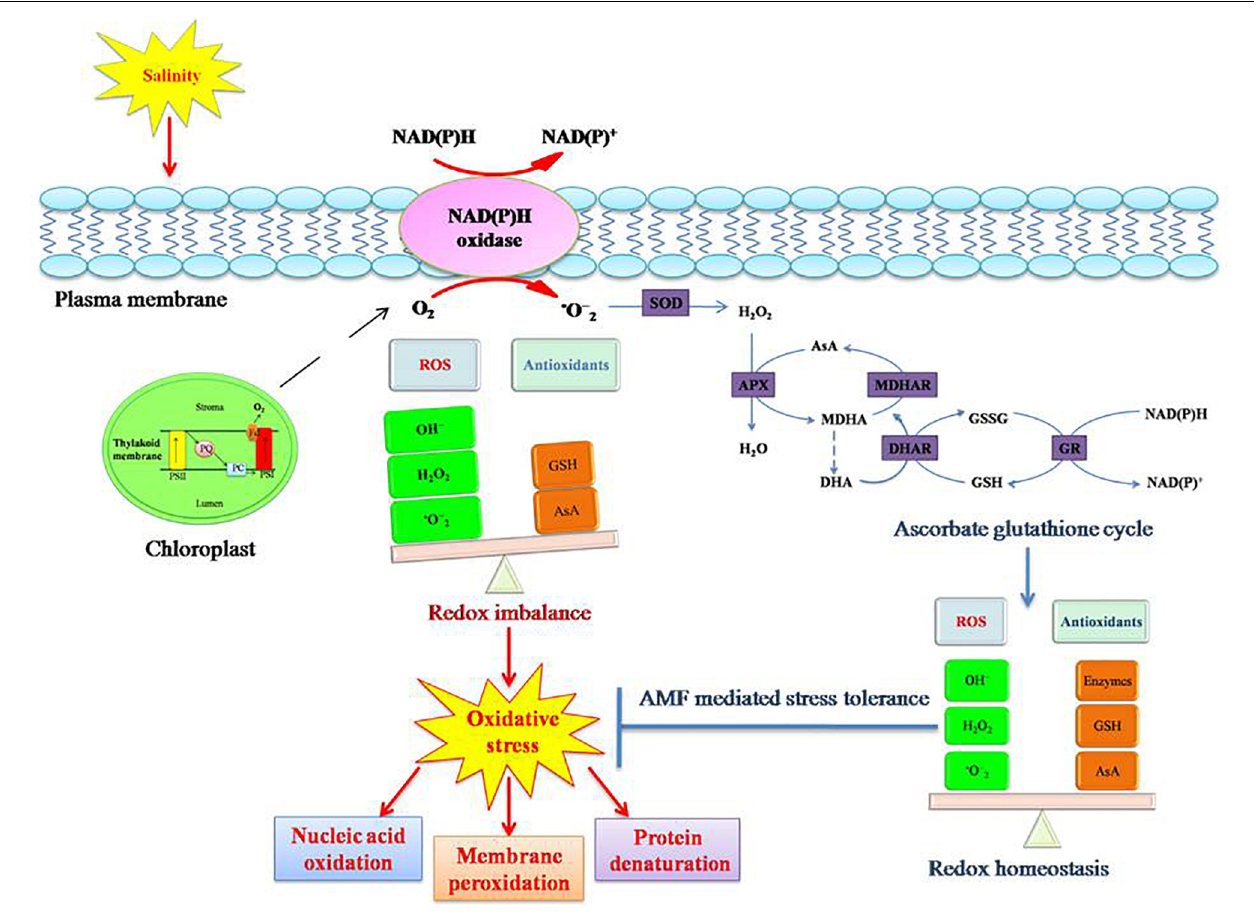
FIGURE 4 | Salinity stress induced oxidative stress tolerance mechanism in plants. Salinity causes oxidative stress in plants due to redox imbalance resulting from disturbance in equilibrium between ROS (reactive oxygen species) and antioxidants. Increased ROS concentration in the cell results in protein denaturation, membrane peroxidation, and nucleic acid denaturation. This consequently disturbs the normal functioning of the cell. To counteract the adverse consequences, plants induce antioxidative pathways (enzymatic and non-enzymatic). Enzymatic antioxidants include superoxide dismutase (SOD), peroxidase (POX), catalase (CAT), ascorbate peroxidase (APX), monodehydroascorbate reductase (MDHAR), dehydroascorbate reductase (DHAR), and glutathione reductase (GR). Non-enzymatic antioxidants include ascorbate (AsA), glutathione (GSH), carotenoids, and α -tocopherol. An efficient antioxidative system abates the oxidative damage in plants. AM symbiosis reinforces the tolerance mechanism of plants to salinity induced oxidative